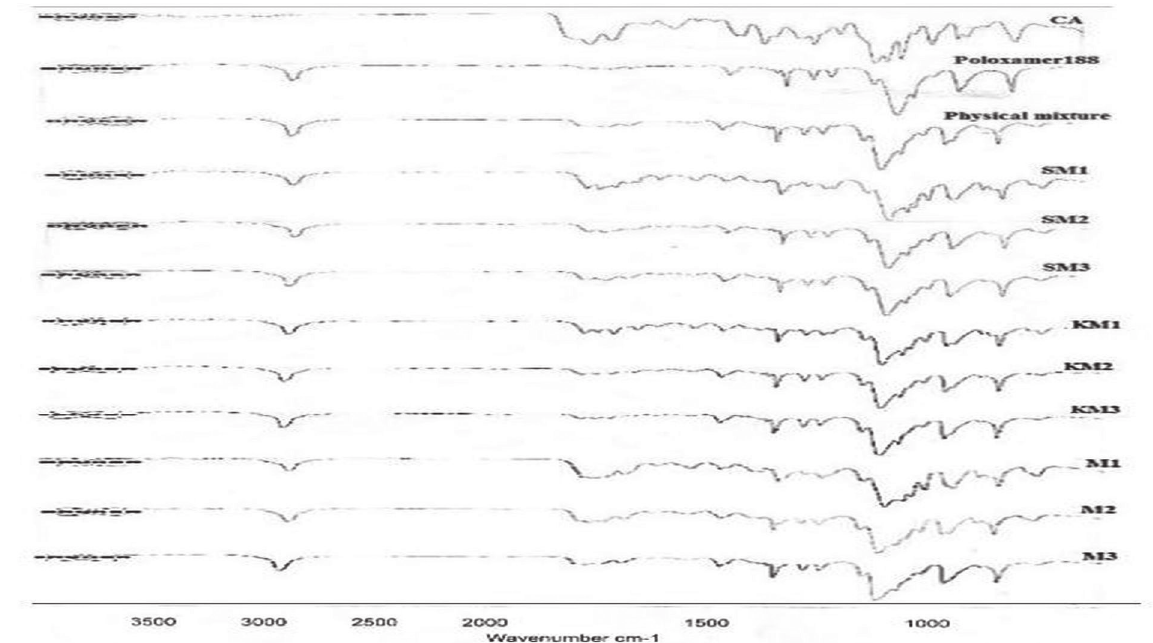
FIGURE 8 - IR spectrum of cefuroxime axetil, poloxamer 188, and their formulations.